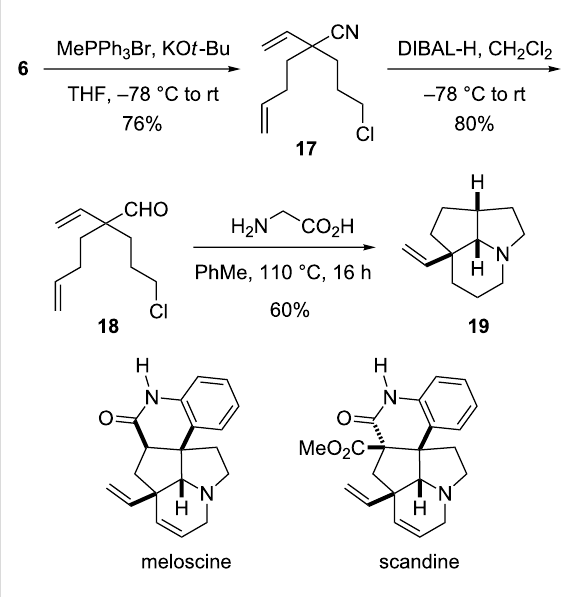
Scheme 6: Synthesis of the core tricyclic ring system of meloscine and scandine.